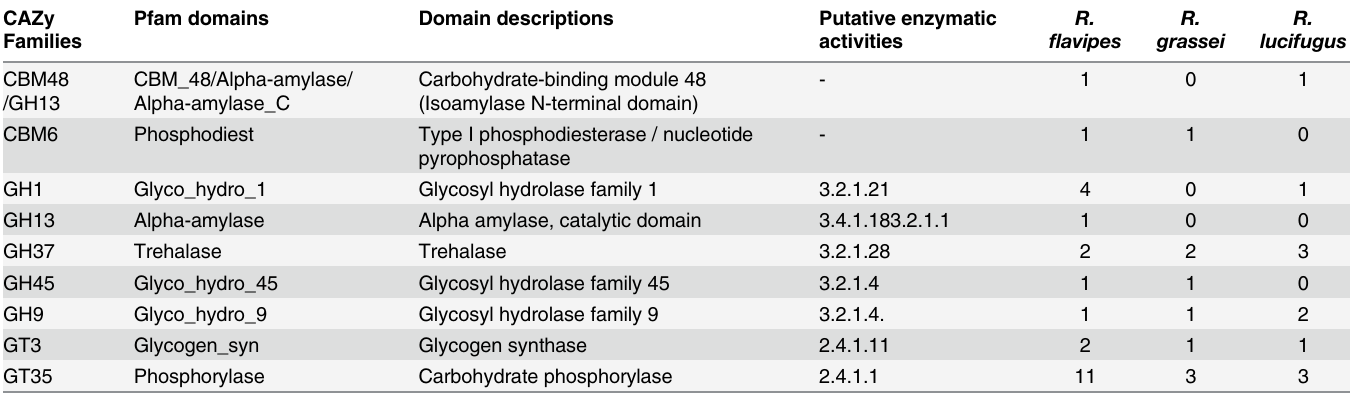
Table 4. Number of Carbohydrate-Active Enzyme (CAZy) families detected in Reticulitermes transcriptomes. CAZy